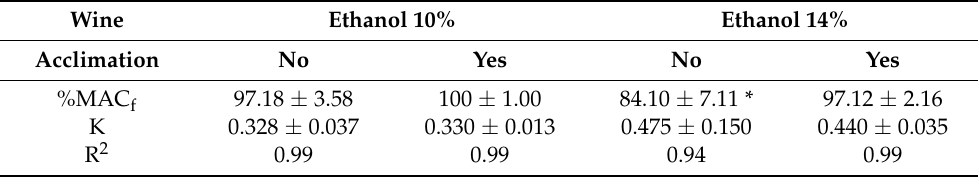
Table 2. Parameters obtained from Figure 5 by application of Equation (2). Wine Ethanol 10% Ethanol 14% Acclimation No Yes No Yes %MAC f 97.18 ± 3.58 100 ± 1.00 84.10 ± 7.11 * 97.12 ± 2.16 K 0.328 ± 0.037 0.330 ± 0.013 0.475 ± 0.150 0.440 ± 0.035 R 2 0.99 0.99 0.94